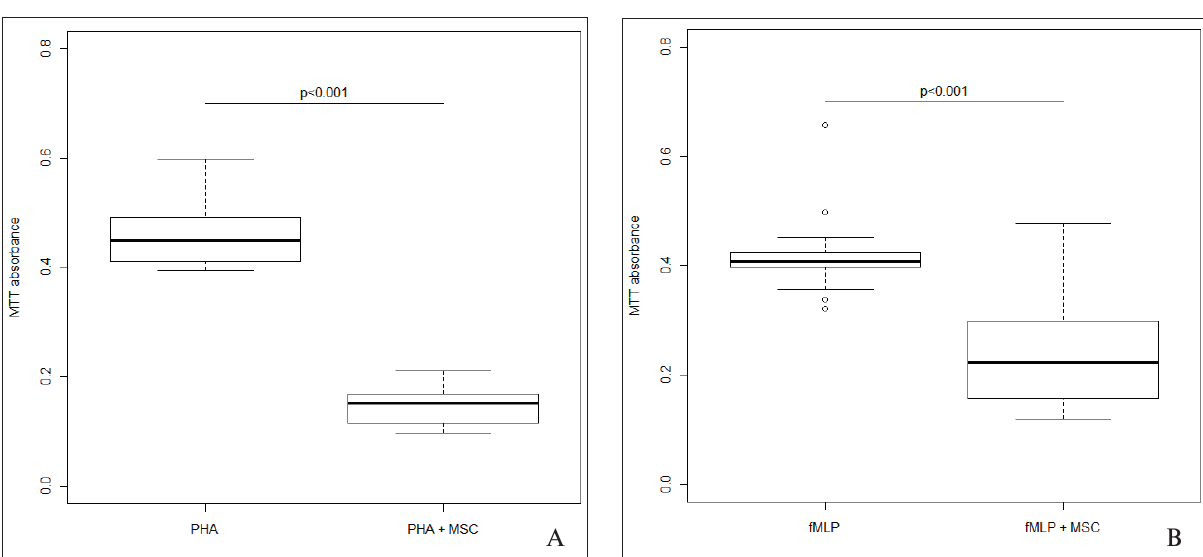
A Fig. 2. Reduction of stimulated lymphocytes metabolic activity after MSC addition (nonspecific stimulation). The effect of MSC addition to the culture of lymphocytes stimulated with PHA (A.) and fMLP (B.). Cocultivation with MSC reduces significantly the metabolic activity of lymphocytes ( P <0.001). Abbreviations: fMLP – N-formyl-Met-Leu-Phe, PHA – phytohemagglutinin. MTT absorbance values showed, Wilcoxon pair test (median; box: 25%, 75% quantiles; non-outlier min, non-outlier max)